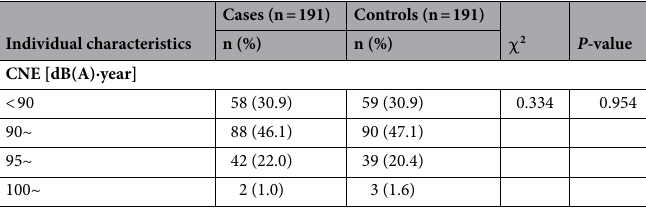
Table 1. Distribution of different characteristics in the two